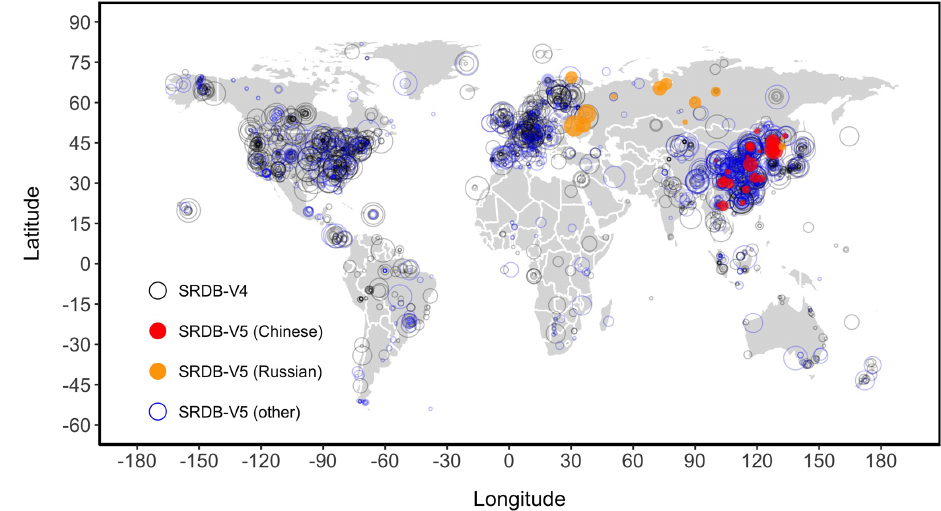
Figure 2. Spatial distribution of soil respiration ( R S ) sites. The gray circles are R S sites from the fourth version of the global soil respiration database (SRDB-V4; n = 1584); the red dots are sites from the literature published in Chinese and added in the fifth version of the global soil respiration database (SRDB-V5; n = 41); the orange dots represent sites from the literature published in Russian and added in SRDB-V5 ( n = 16); the blue dots are sites from the literature published in other languages (mainly in English) and added in the SRDB-V5 ( n = 840). The size of circles represents the sample size at each measurement site (i.e., bigger circles represent more